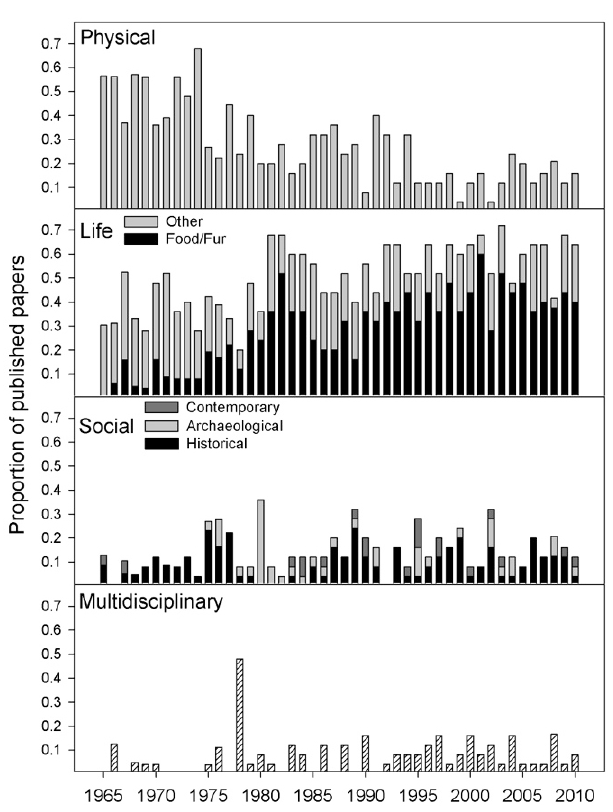
Fig. 3 . The organizational composition of research included in our analysis of research papers published in Arctic 1965-2010.